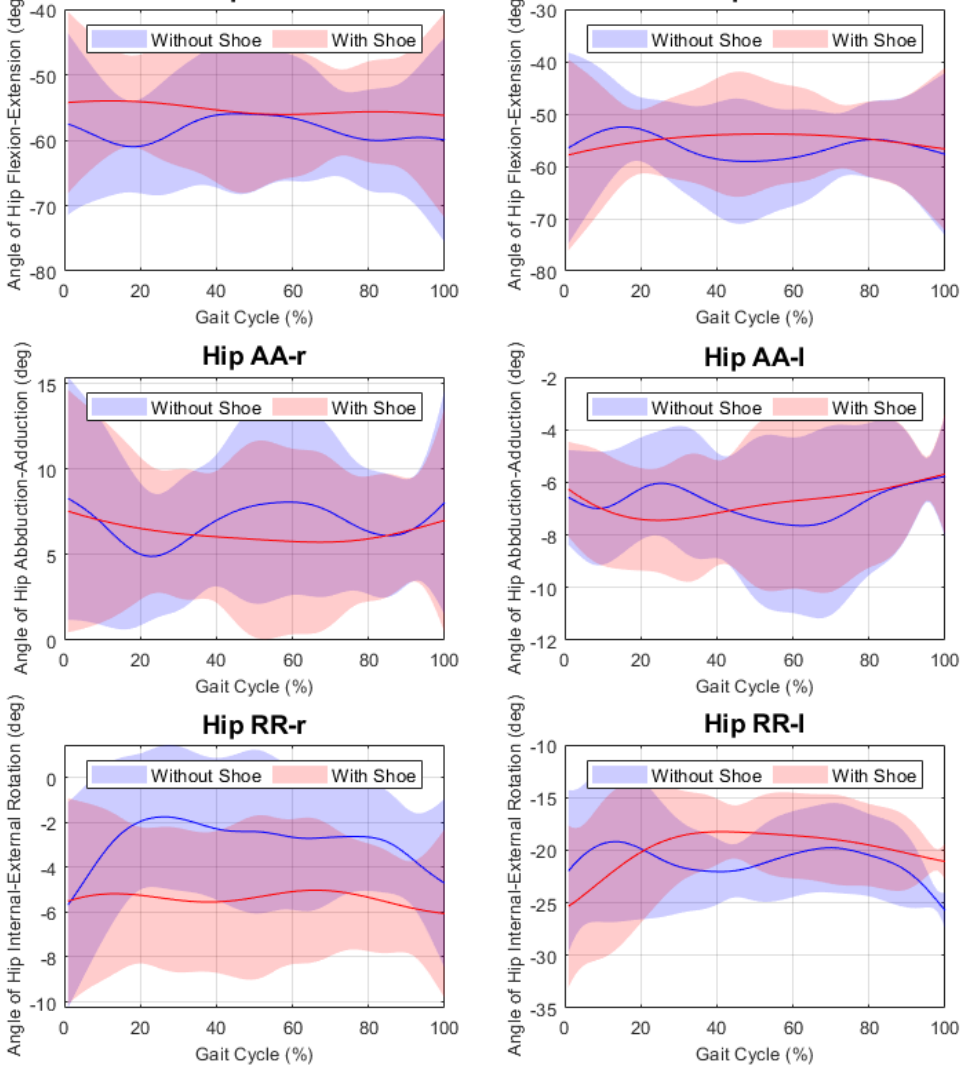
Figure 3. Hip kinematics of flatfoot subject with and without running shoes. r-right; l-left; FE- flexion/extension; AA-abduction/adduction; RR-internal/external